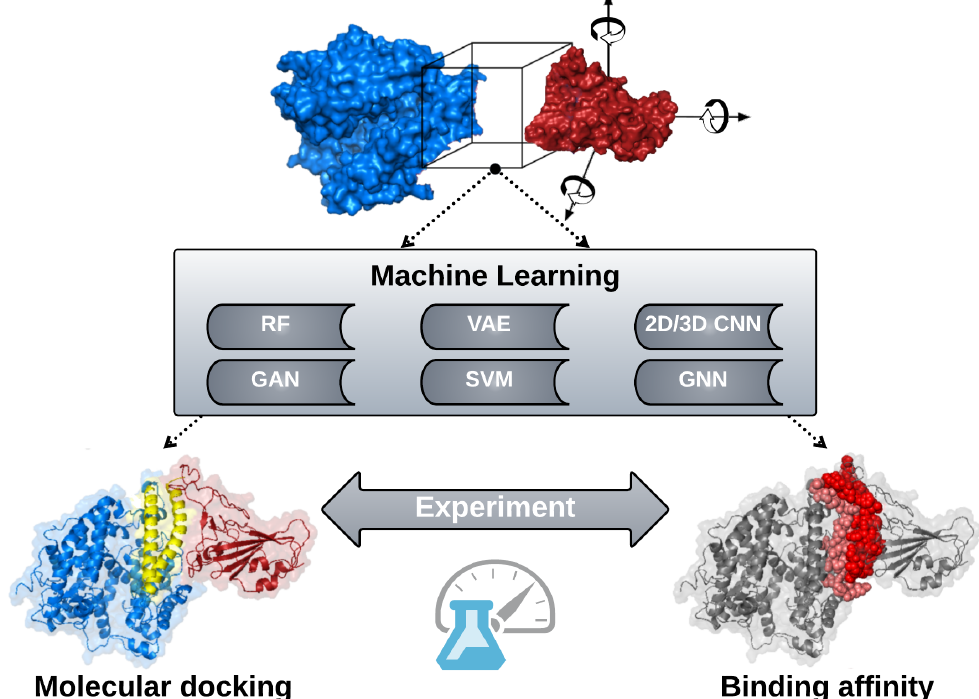
Figure 7. Computational drug discovery relies on the interplay between molecular docking and binding affinity prediction, both of which have been enhanced by ML. Docking methods can use ML to account for subtleties in molecular interaction such as flexibility or predict inter-molecular contacts, while ML-powered binding affinity functions score poses. In both cases, experimental data are used to train models, and methods will continue to improve as more data are